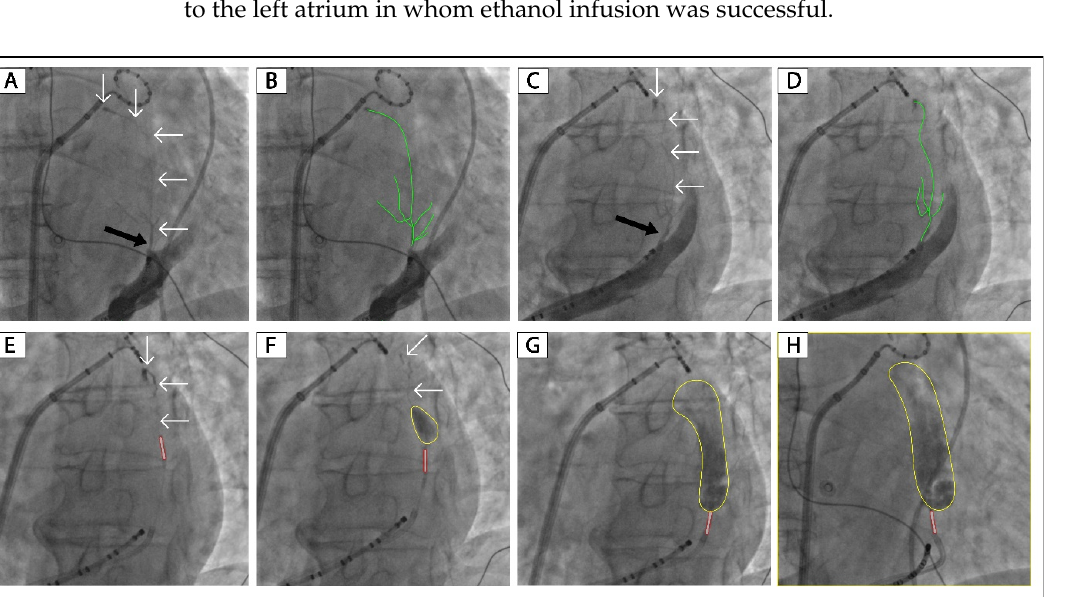
Figure 2. Successful ethanol infusion in a VOM with collateral circulation to the left atrium. ( A , C ): Non ‐ occluded venograms of VOM in the RAO and LAO projection, respectively. ( B , D ): Highlighted VOMs of panels ( A , C ), respectively. ( E – G ): Balloon occluded venograms of VOM in the LAO projection after 2, 4, and 8 mL of ethanol infusion, respectively. ( H ): Balloon occluded venogram of VOM in the RAO projection after 8 mL of ethanol infusion. The black arrow indicates the ostium of VOM. The white arrows and green lines indicate the drainage of the VOM. The tubule outlined in red indicates the angioplasty balloon. The yellow circles indicate localized myocardium staining. VOM, the vein of Marshall; RAO, right anterior oblique; LAO, left anterior oblique.